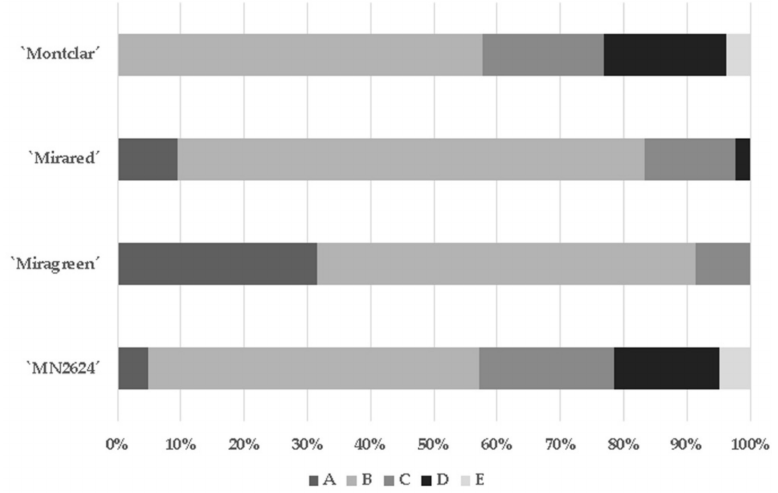
Figure 7. Internal characterization of the graft unions for each rootstock based on the Herrero classification (1951). Graphic represents the proportion (%) of the category A to E detected per graft